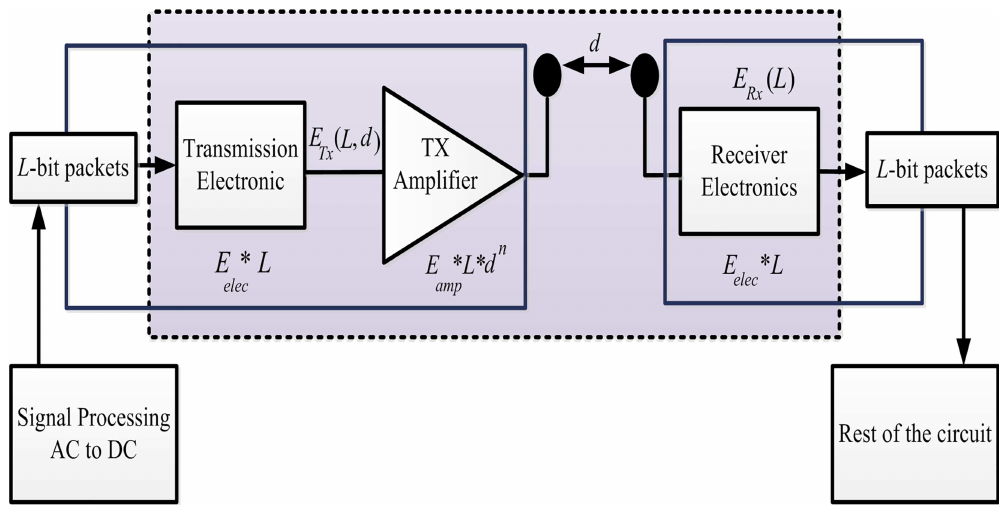
Fig 3. Radioenergy dissipation